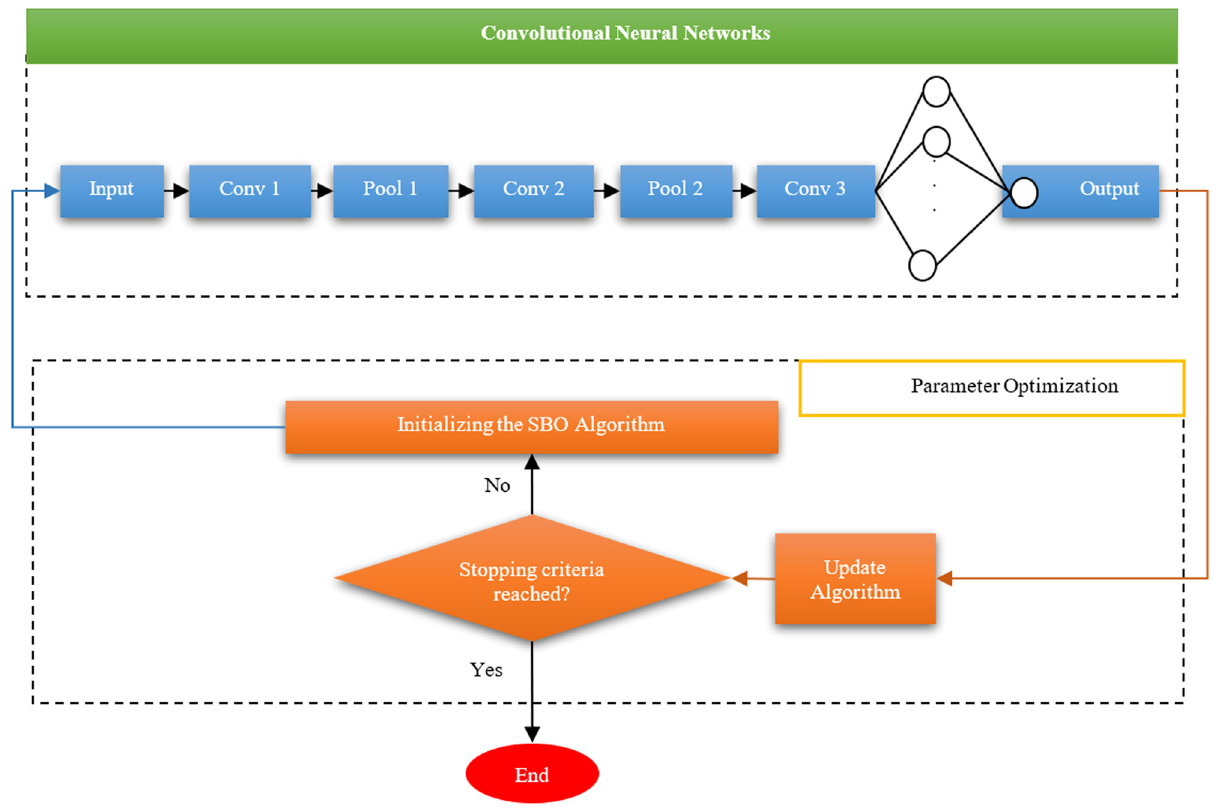
Figure 3: The optimized structure of the SBO - based CNN.